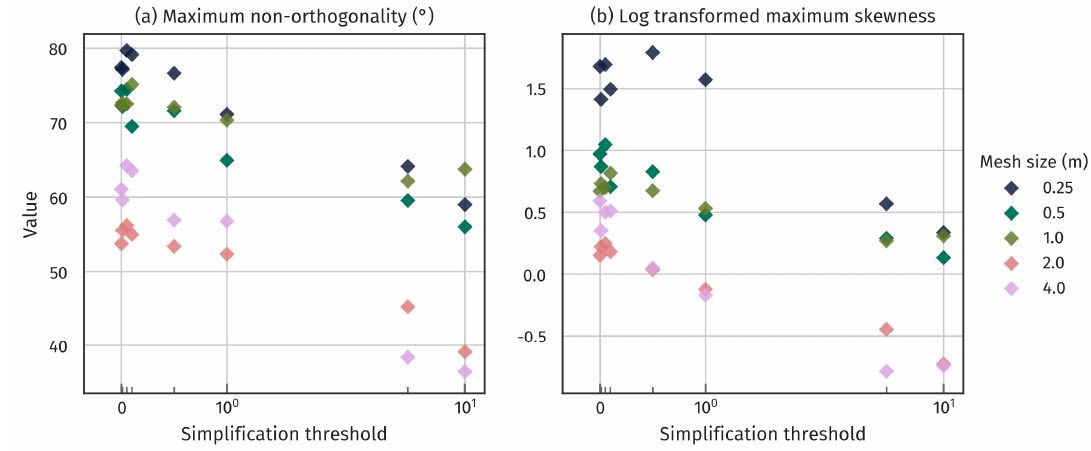
Figure 10. Mesh quality according to simplification threshold and mesh size.